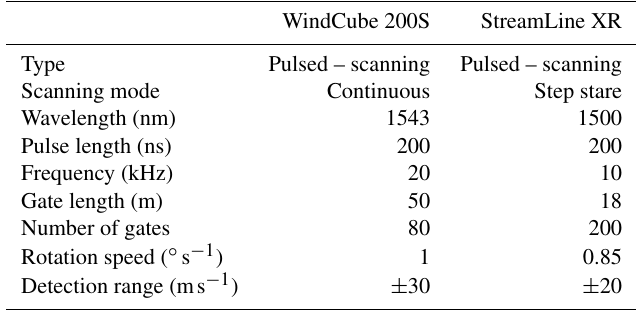
Figure 2. Photographs of the lidar experiment. (a) Lidar WindCube 200S and sonic anemometers (Campbell Scientific, Inc.; CSAT3). (b) Lidar StreamLine XR. (c) GE 1.5sle turbines of the B row. Table 2. Technical specifications and settings of the wind lidars deployed during the field campaign.